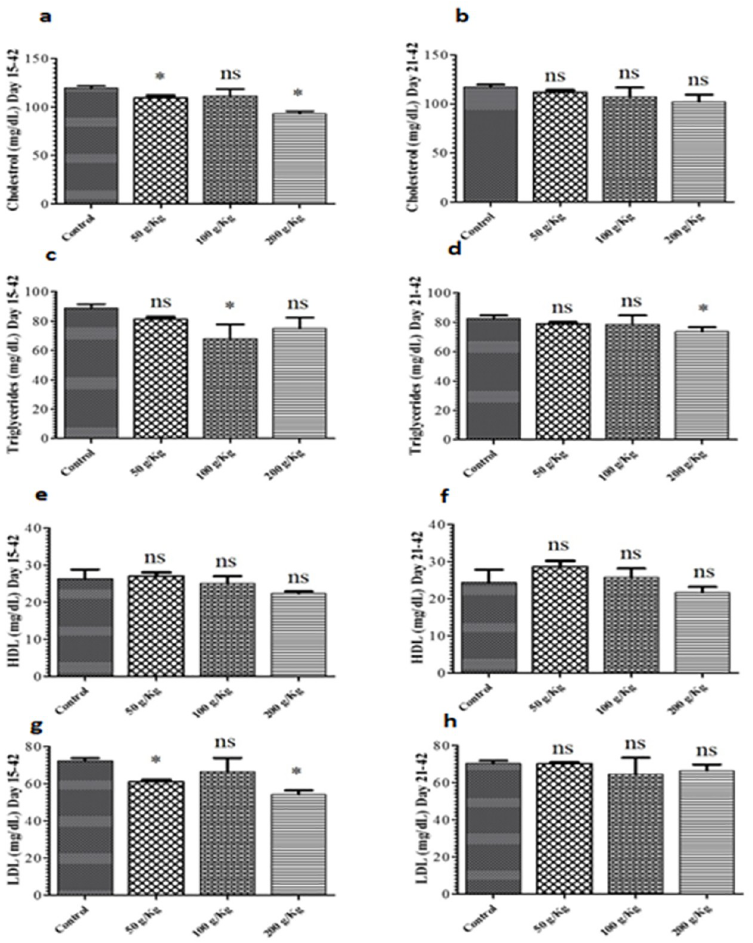
Fig 6. Graph showing the comparison of cholesterol of different quinoa enriched diet given chicken groups fed from days 15 to 42 post-birth (growth phase) and days 21 to 42 post-birth (finisher phase). The chickens were given 50 g/Kg, 100 g/Kg and 200 g/Kg of Quinoa ( a ). Cholesterol level of chicken fed from days 15 to 42 post-birth ( b ). Cholesterol level of chicken fed from days 21 to 42 post-birth ( c ). Triglycerides level of chicken fed from days 15 to 42 post-birth ( d ). Triglycerides level of chicken fed from days 21 to 42 post-birth ( e ). High-density lipoproteins (HDL) of chicken fed from days 15 to 42 post-birth ( f ). High-density lipoproteins (HDL) of chicken fed from days 21 to 42 post- birth ( g ). Low-density lipoproteins (LDL) of chicken fed from days 15 to 42 post-birth ( h ). Low-density lipoproteins (LDL) of chicken fed from days 21 to 42 post-birth. All data are expressed as means ± standard deviation (SD) from measurements on 15 chickens. � p � 0.05 in all Quinoa supplemented diet fed groups versus the commercially available diet without Quinoa fed control group. Note : ns means not significant.